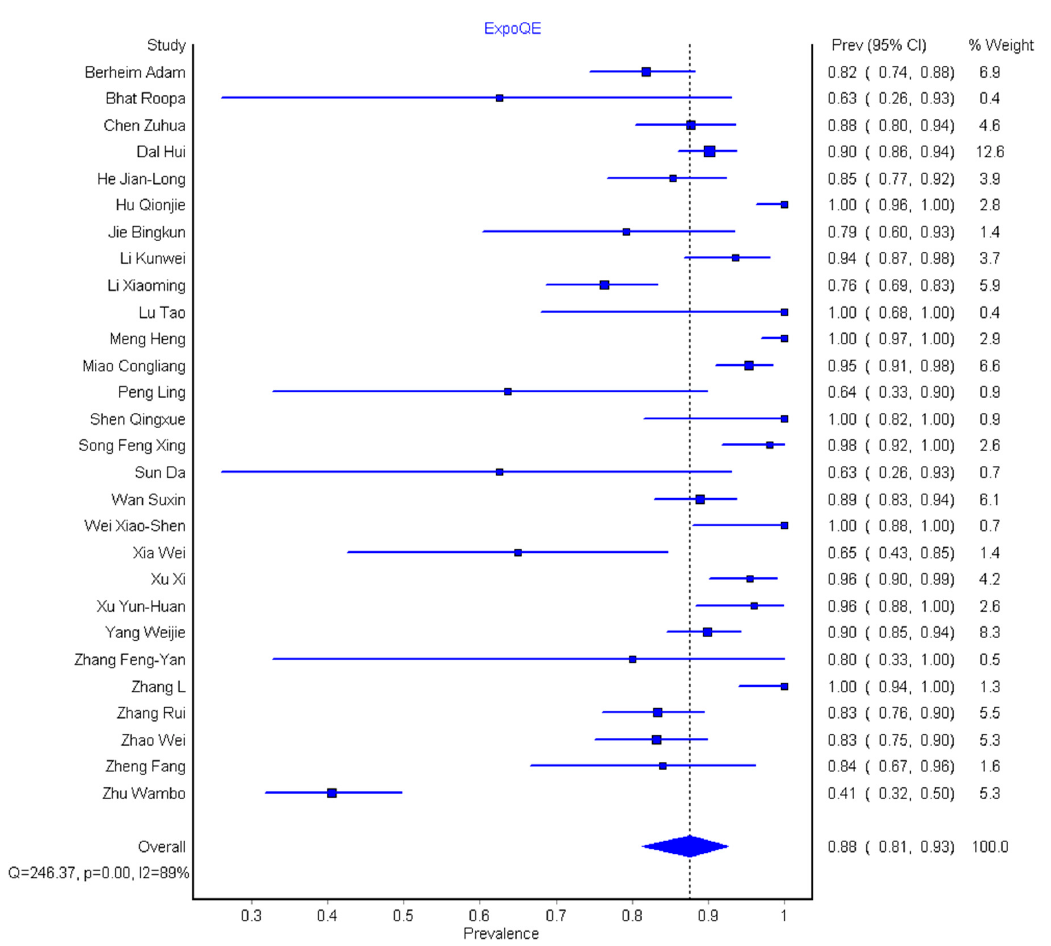
Figure 5. Forest plot of the studies for the pooled prevalence of exposure history for 28 included patients.